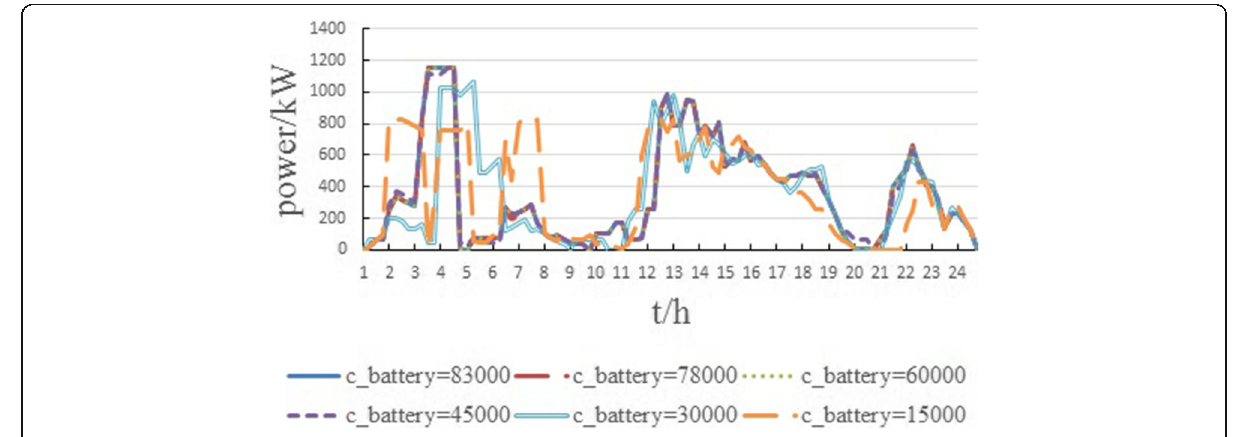
Fig. 9 Charging power curves with different battery costs at a workday in Summer (PV capacity = 1000 kW)